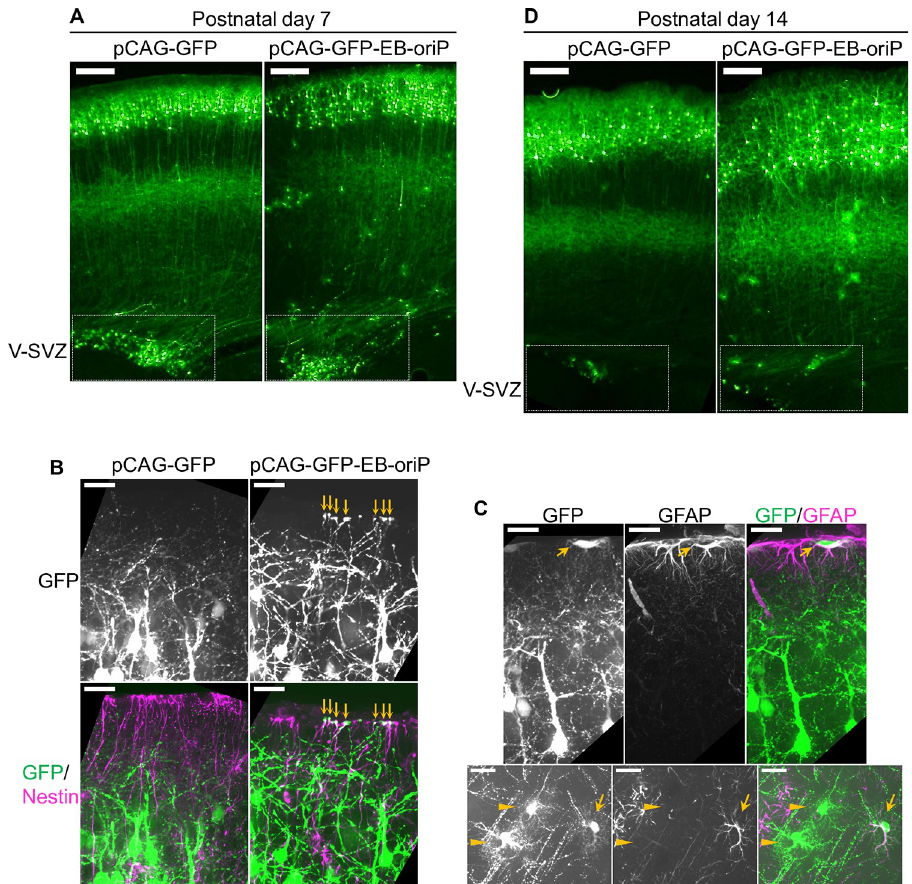
Fig 3. Transgene expression in radial glial cells by IUE of the EB-oriP plasmid in early postnatal mice. (A and D) GFP fluorescence images of coronal sections at P7 (A) and P14 (D) from the brains transfected at E15 with pCAG-GFP and pCAG-GFP-EB-oriP. Scale bars: 200 μ m. (B) GFP-labeled cells in the superficial region at P7 and immunostaining for Nestin. Arrows indicate the parts of GFP-labeled cells that are Nestin-positive, which appeared to be radial glial endfeet. Scale bars: 25 μ m. (C) GFP-labeled cells at P7 morphologically appeared to be astrocytes immunostained for GFAP. Arrows in upper and lower panels and arrowheads in lower panels indicate GFAP-positive or -negative cells, respectively. Scale bars: 25 μ